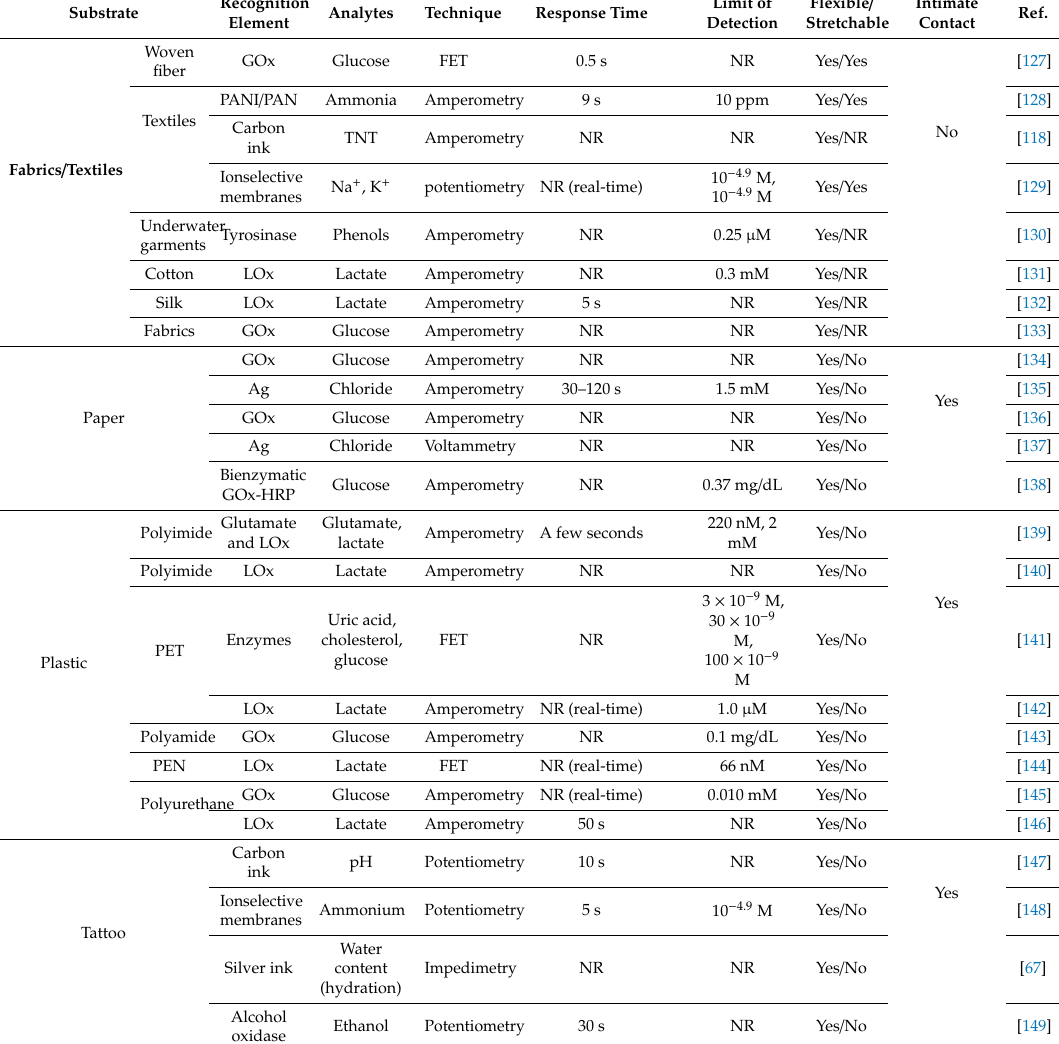
Table 4. Summary of representative electrochemical sensors based on di ff erent substrates.